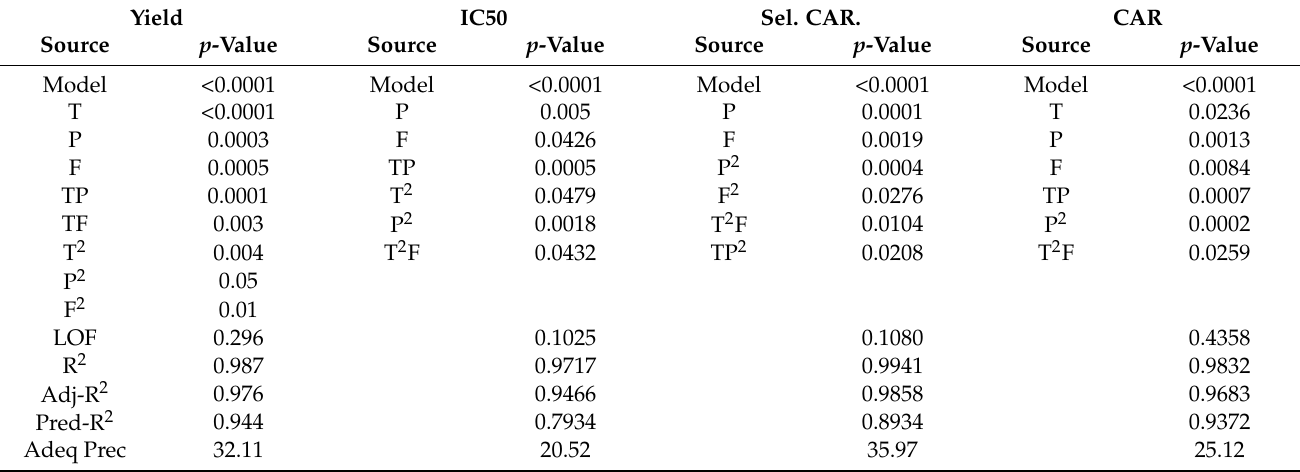
Table 2. The main ANOVA results and adequacy measures of the responses examined for the SFE of C. vulgaris